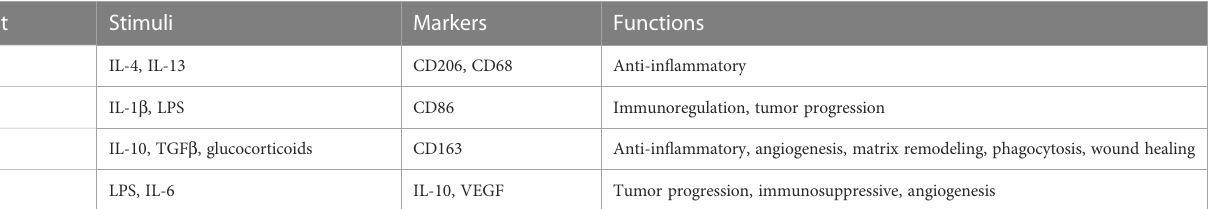
TABLE 2 M2-type macrophages subsets.